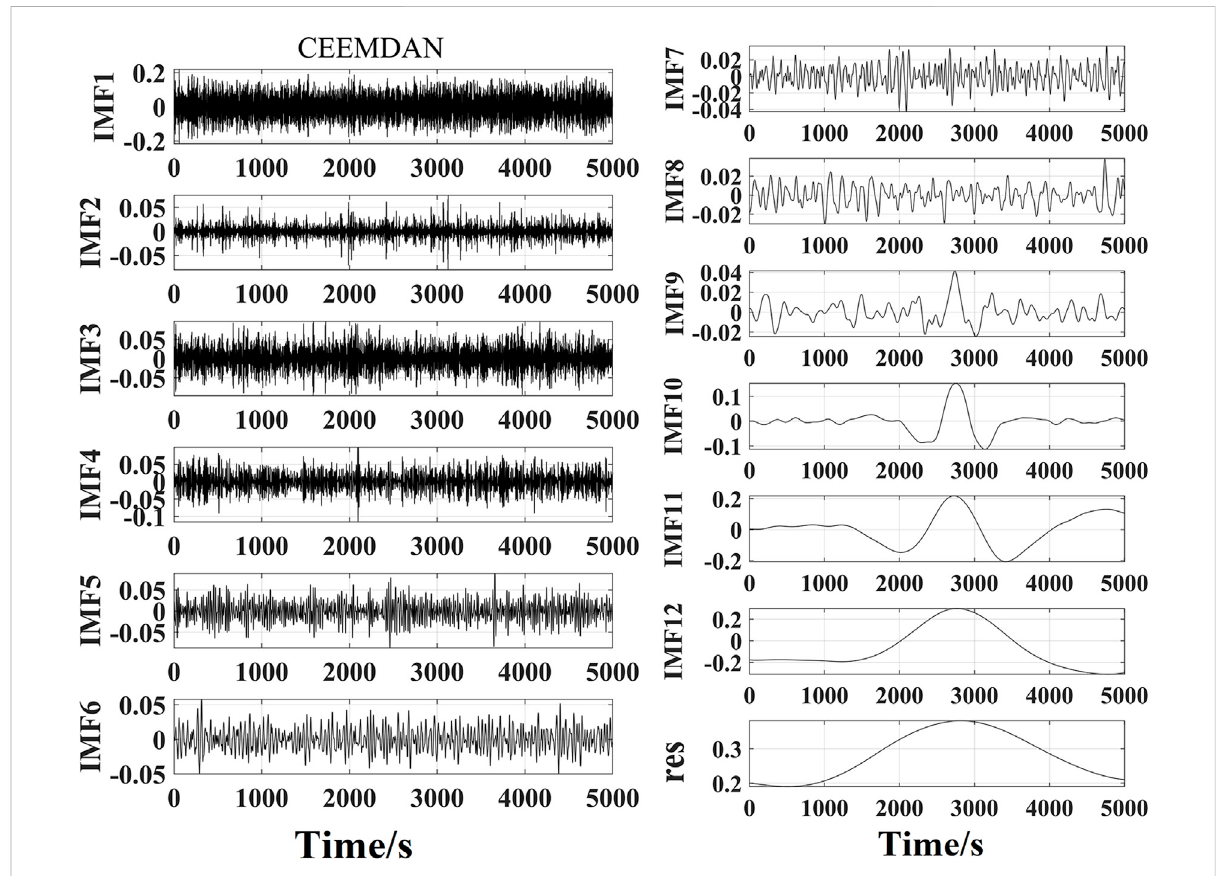
FIGURE 4 Decomposition diagram obtained IMF1-IMF12 using